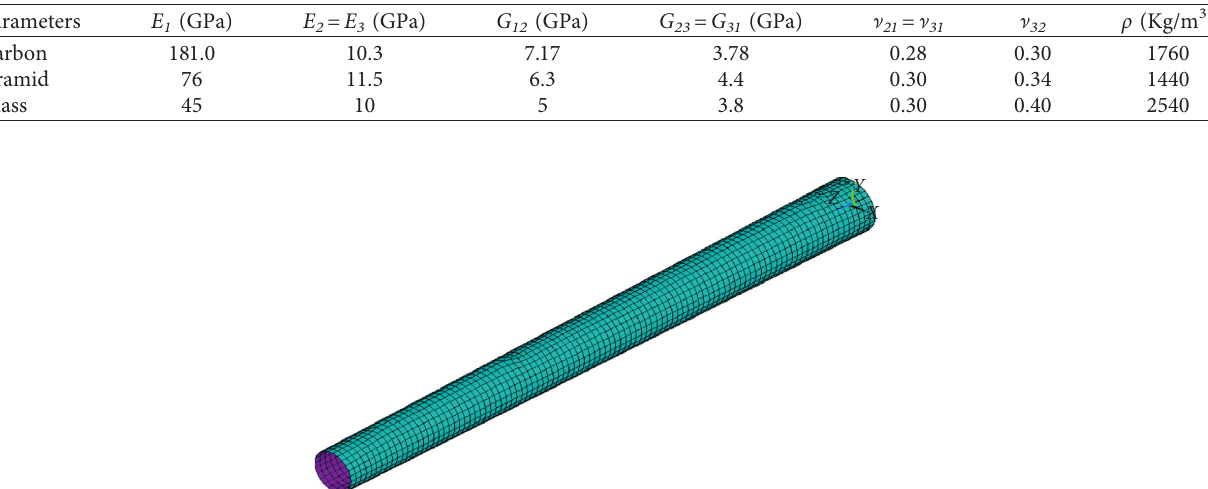
Table 1: Mechanical parameters of three composite materials.